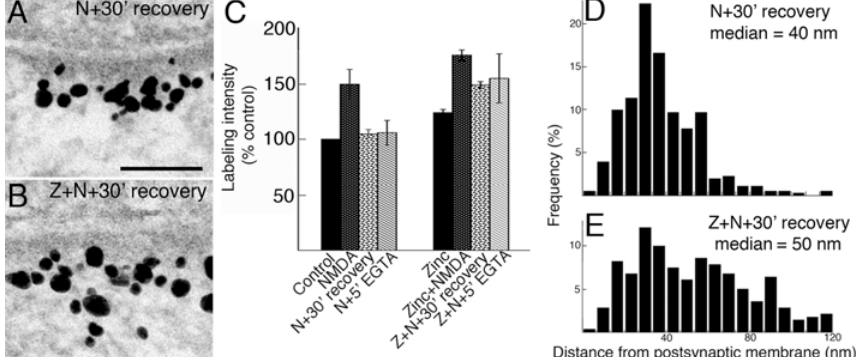
Fig 8. (A, B) Electron micrographs of asymmetric synapses labeled for Shank3 with ab2. Hippocampal cultures were pre-incubated for 1 hr with or without zinc, then exposed to NMDA for 2 min. Samples were either fixed immediately or after NMDA washout under two different protocols (30 min in control media or 5 min in EGTA-containing Ca 2+ -free media). Distribution patterns of label are different in samples that were incubated in the absence (A) or presence (B) of zinc, 30 min after NMDA washout. Scale bar = 0.1 μ m. (C) Bar graphs represent combined data (mean ± SEM) from S7 Table. NMDA-induced increase of label for Shank3 is reversed in the absence of zinc, but largely retained in the presence of zinc. (D, E) Laminar distribution and median distances of gold particles from the postsynaptic membrane were also significantly different. NMDA-induced preferential increase of Shank3 in the distal layer of the PSD is reversible after 30 min recovery in control media (D), but maintained in the presence of zinc